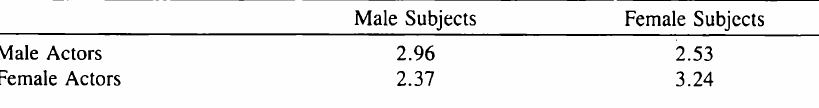
Table 3 Mean Assignment of Sanction Ratings by Male